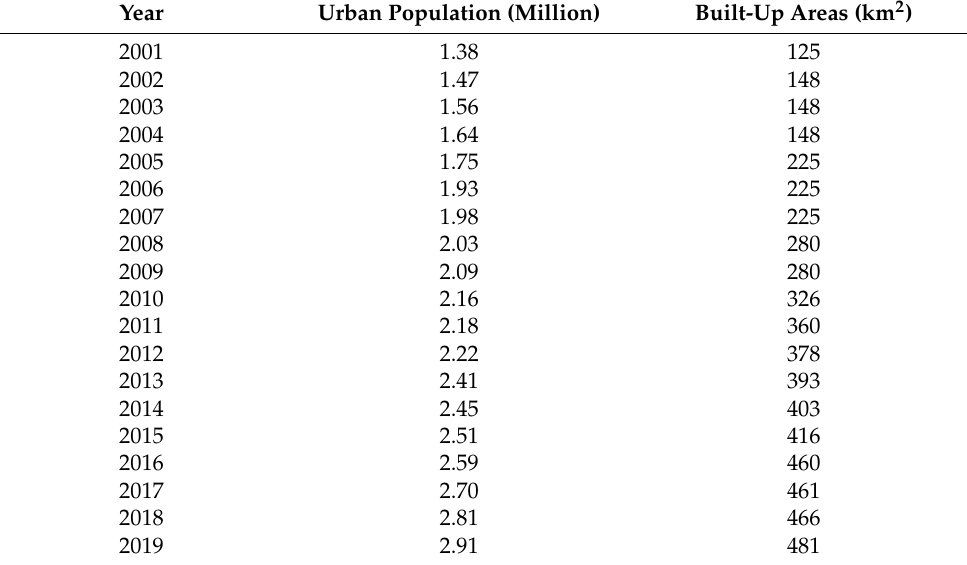
Table 1. Urban population and built-up areas of urban districts of Hefei City from 2001 to 2019 *.